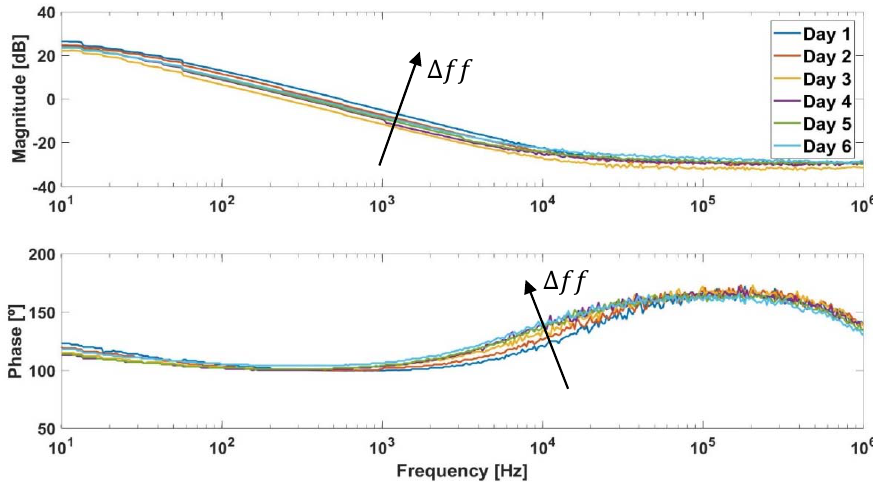
Figure 4. Experimental BioZ bode diagram.